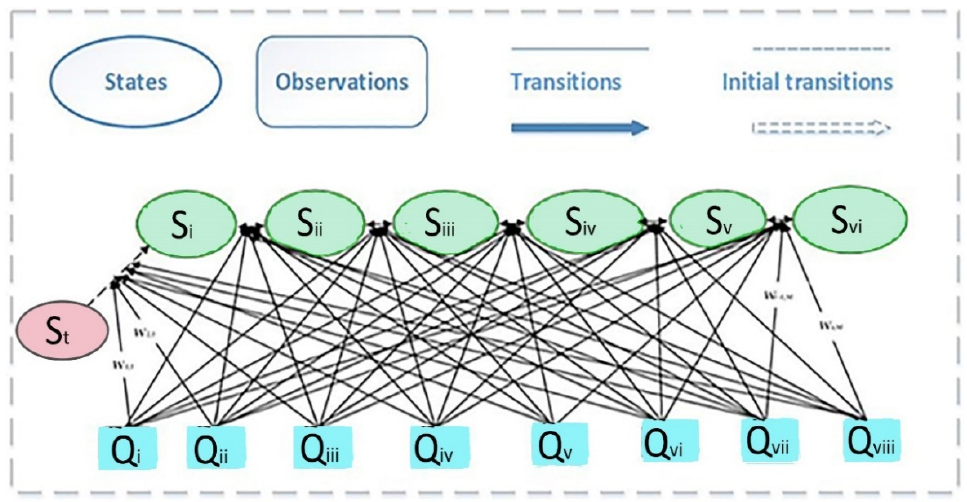
Figure 11. The design diagram of the Maximum Entropy Markov Model algorithm.